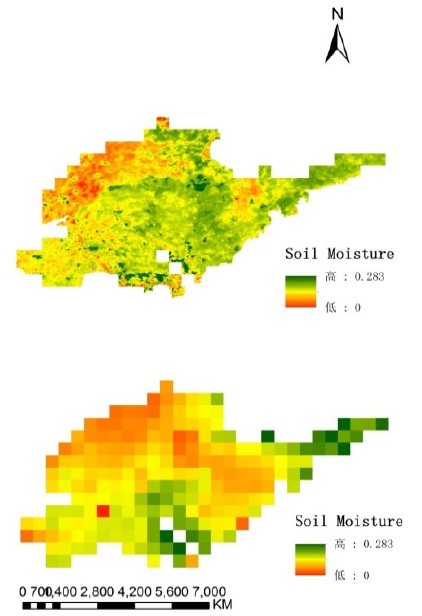
Fig.2 comparison of FY-3B /MWRI original and downscaled soil moisture